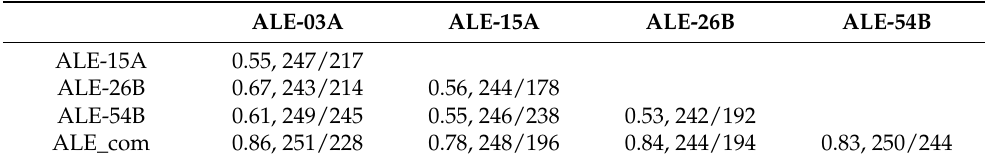
Table 1. Correlation statistics between the individual tree-ring δ 13 C pin series of Alaer ( r ,